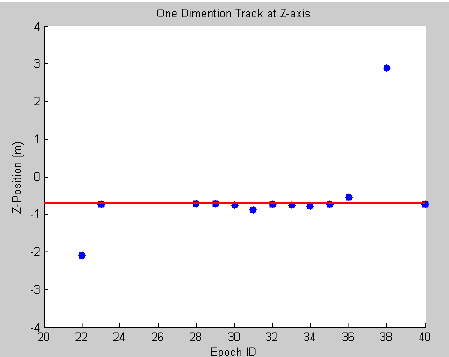
Figure 5. Measured Z position for epoch 20-40